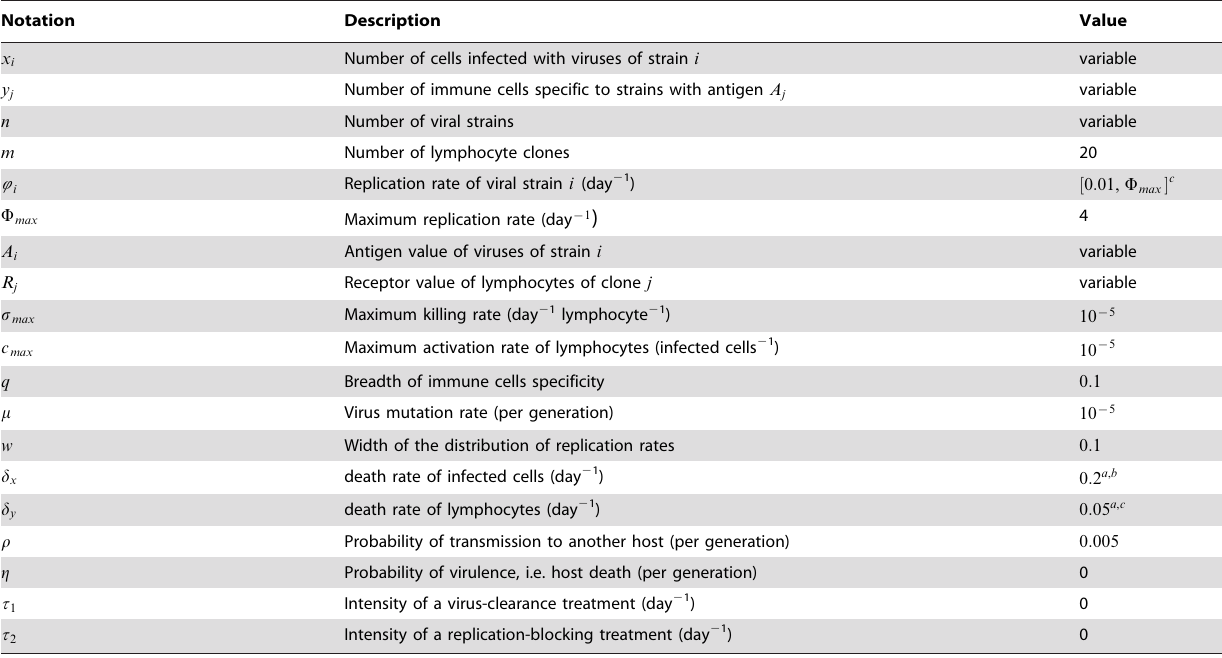
Table 1. List of the variables and parameters of the